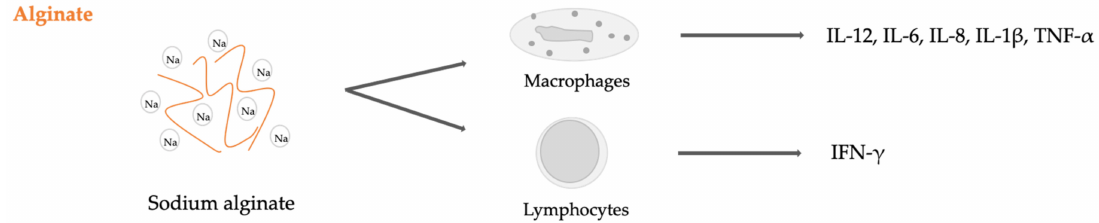
Figure 10. Sodium alginate immune activation of Peripheral Blood Mononuclear Cells